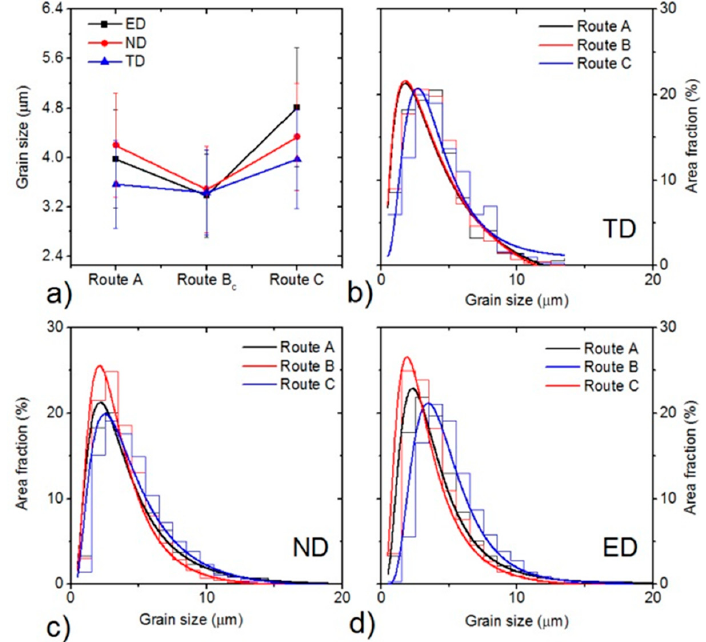
Figure 4. Average grain sizes of the particular samples ( a ). Grain size distributions for the particular ECAP routes in the transversal plane ( b ), normal plane ( c ) and extrusion plane ( d ).